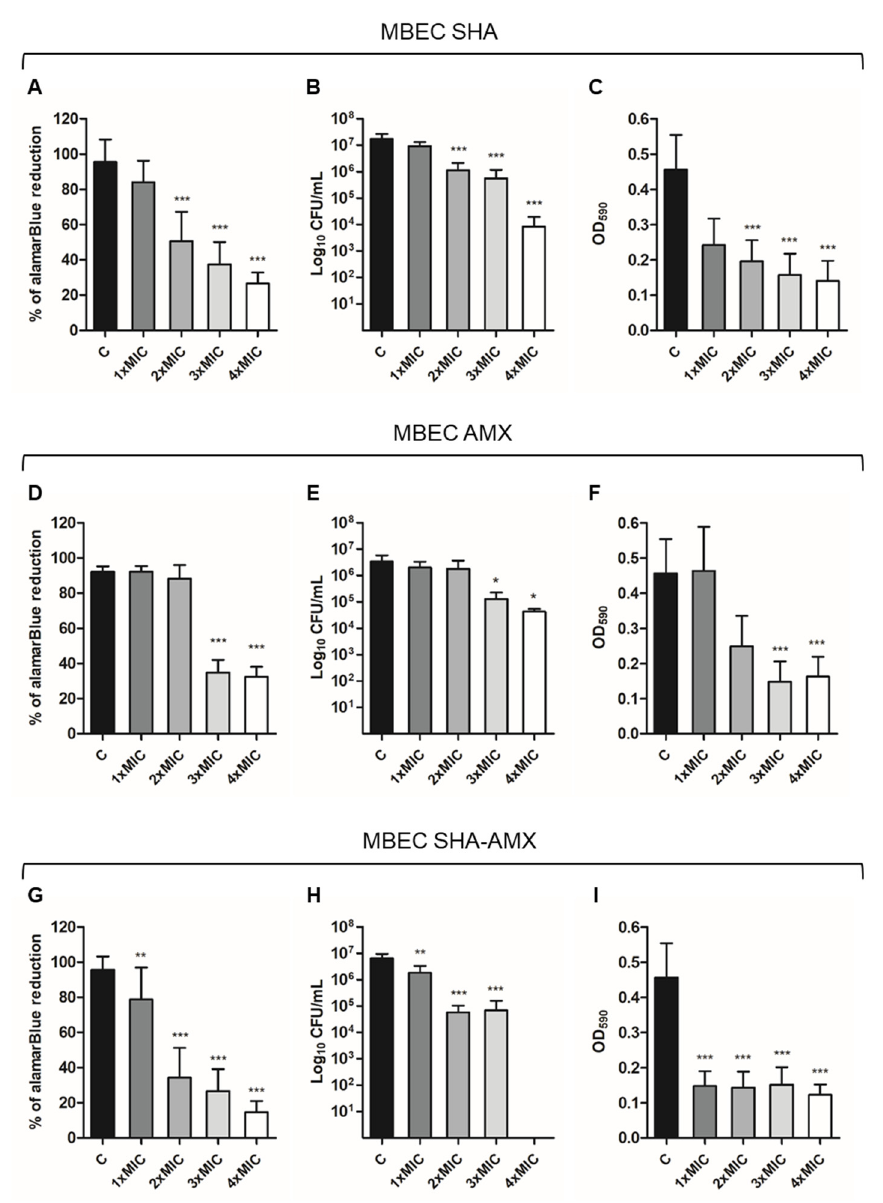
Figure 4. In vitro activity of SHA and AMX alone and in combination against H. pylori preformed biofilm. C: control biofilm (Brucella Broth with the addition of ethanol and H 2 O at the concentrations present in 1×, 2×, 3×, 4×MIC); 1×MIC: biofilm treated with SHA and AMX at MIC concentrations (SHA 64 μ g/mL ‐ AMX 0.008 μ g/mL); 2×MIC: biofilm treated with SHA and AMX at 2×MIC concentrations (SHA 128 μ g/mL ‐ AMX 0.016 μ g/mL); 3×MIC: biofilm treated with SHA and AMX at 3×MIC concentrations (SHA 192 μ g/mL ‐ AMX 0.024 μ g/mL); 4×MIC: biofilm treated with SHA and AMX at